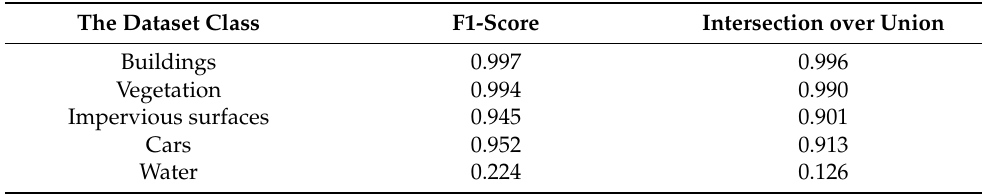
Table 1. Quantitative results of Plf4SSeg approach.